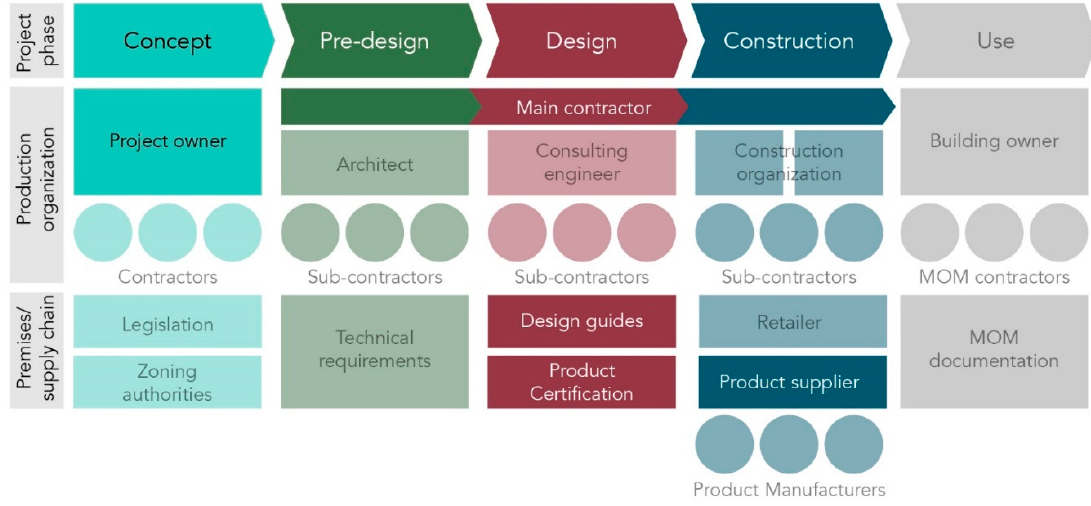
Figure 2. Illustration of the building process and its main involved actors in a design–build (DB) contract delivery model. Actors and phases considered outside the scope of this article are shown in faded colors. The inclusion of actors in this article represents all project phases until the point of handover, and actors both within and outside the production organization. The split boxes under “construction organization” denote a larger organization with more sub-contractors than what is common in the other phases.